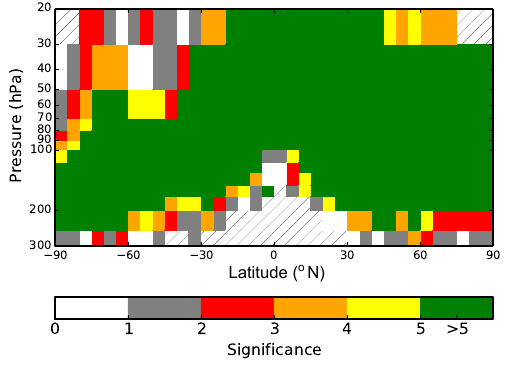
Figure 12. Map of the ratio between CCl 4 trends and associated random